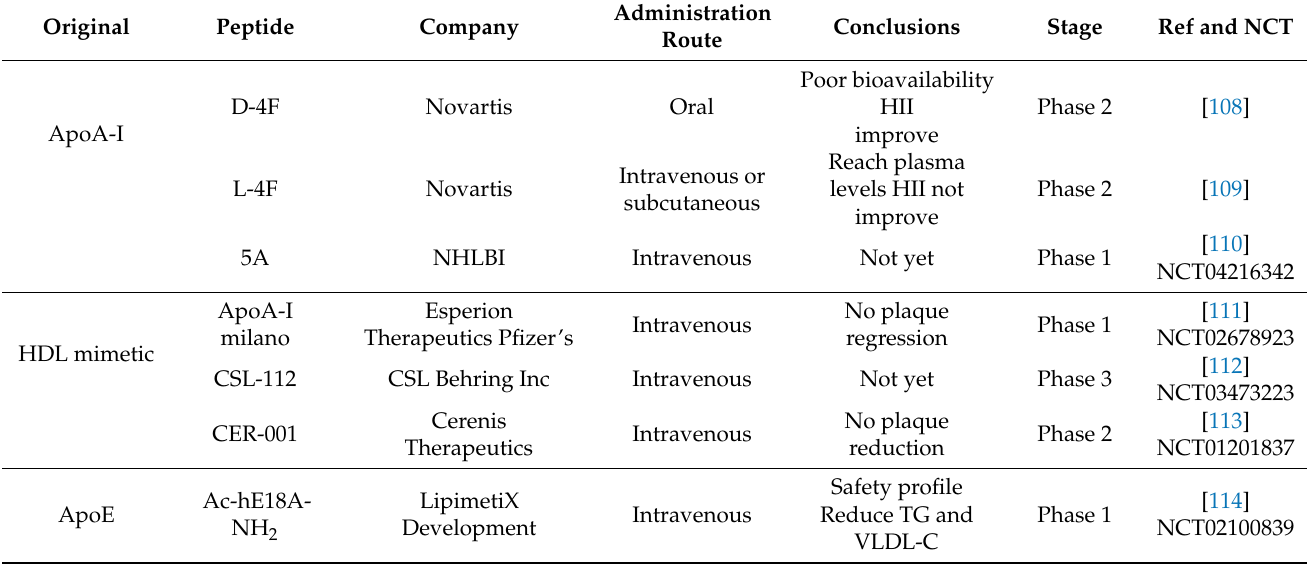
Table 3. Apolipoprotein and HDL-mimetic peptides in clinical